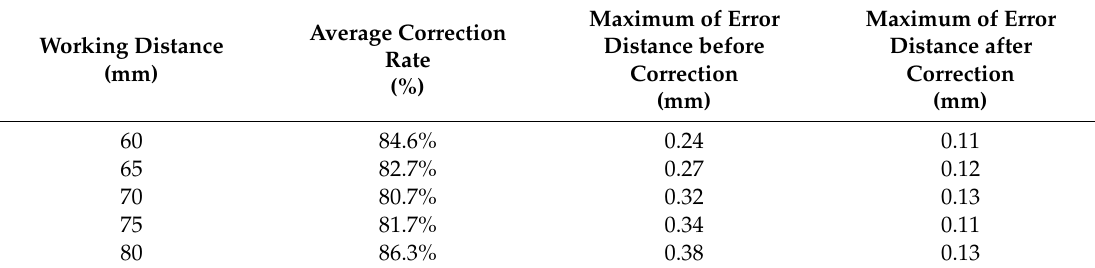
Table 1. The maximum error of the corresponding lines in the corrected stereo images and the correction rate according to the working